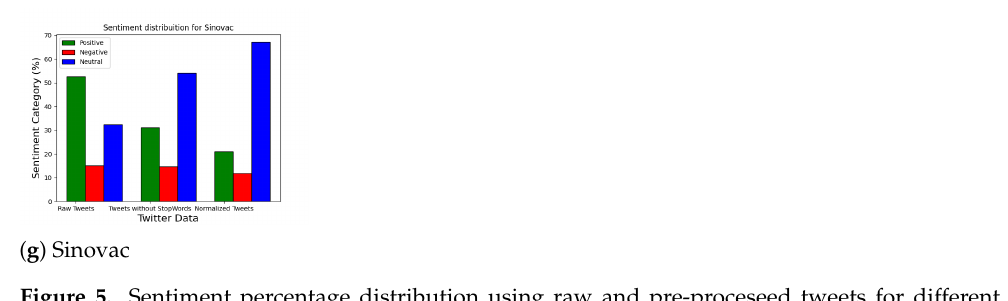
Figure 5. Sentiment percentage distribution using raw and pre-proceseed tweets for different vaccines.